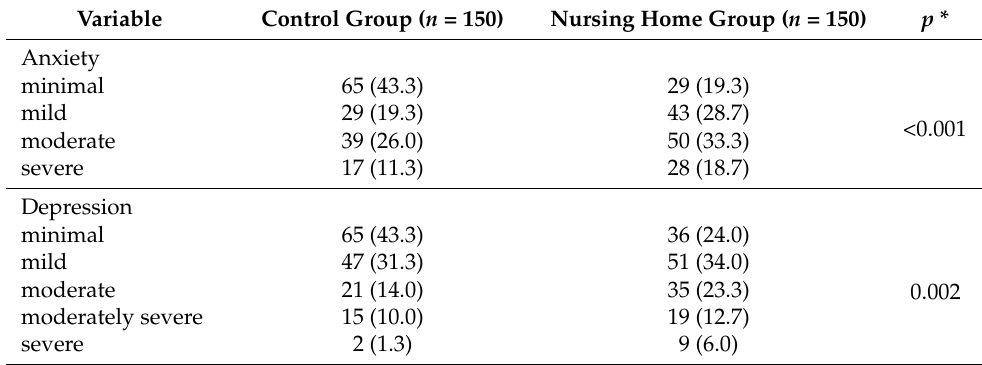
Table 3. Distribution of anxiety and depression in older people, n